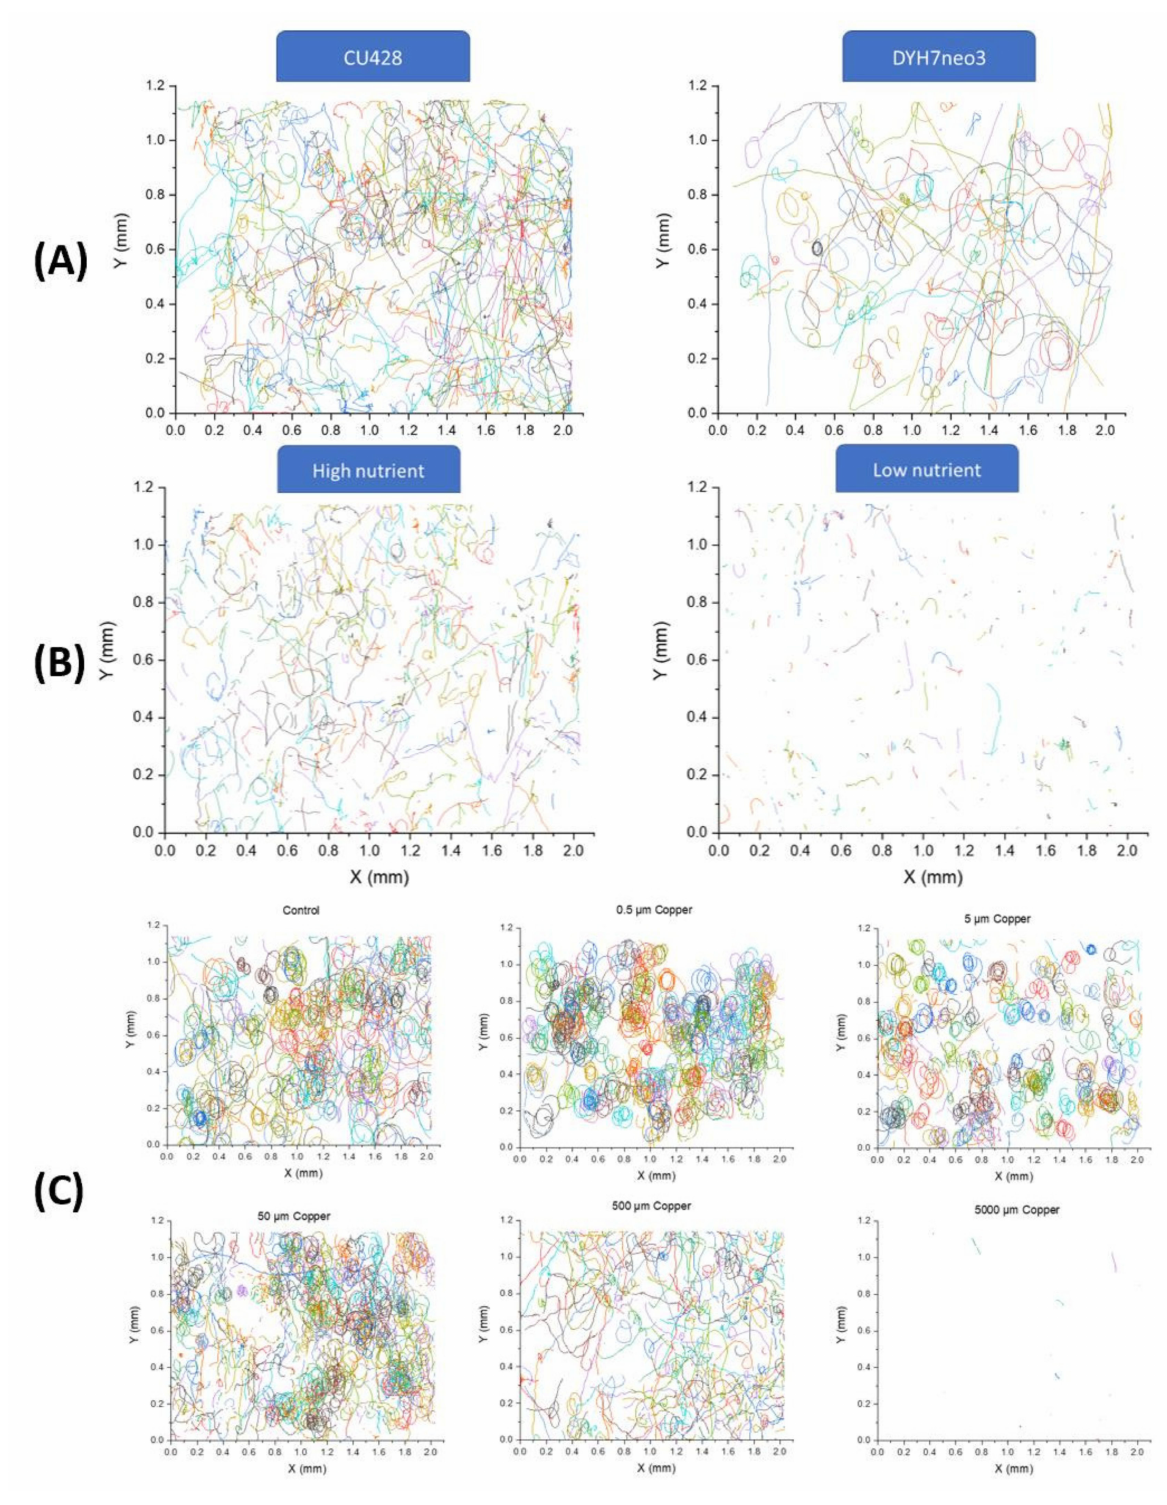
Figure A1. The footage of Tetrahymena cell movement in different conditions. ( A ) Trajectory compar- ison of wild-type (CU428 strain) and mutant (DYH7neo3) Tetrahymena . ( B ) Trajectory comparison of Tetrahymena cells in high- and low-nutrient media. ( C ) Trajectory comparison of Tetrahymena locomotion after exposed to CuSO 4 of different concentrations (0–5000 µ